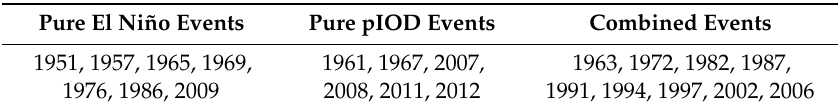
Table 1. List of pure El Niño, pure positive Indian Ocean Dipole (IOD) (pIOD), and combined events during